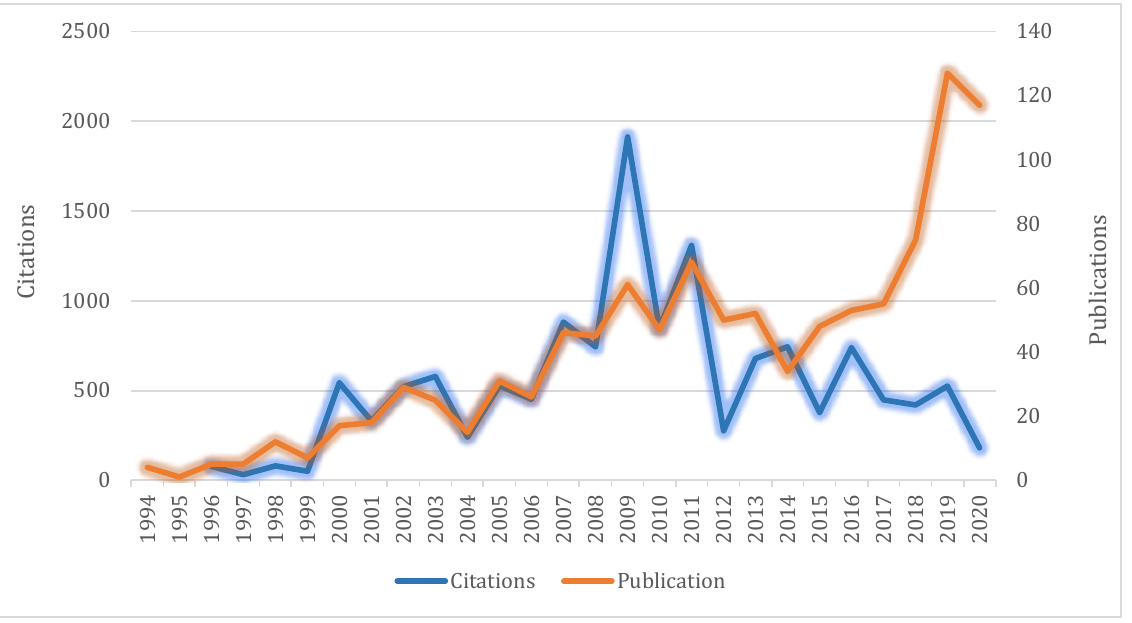
Figure 2. Publications and citation trends in VR from 1994 – 2020.